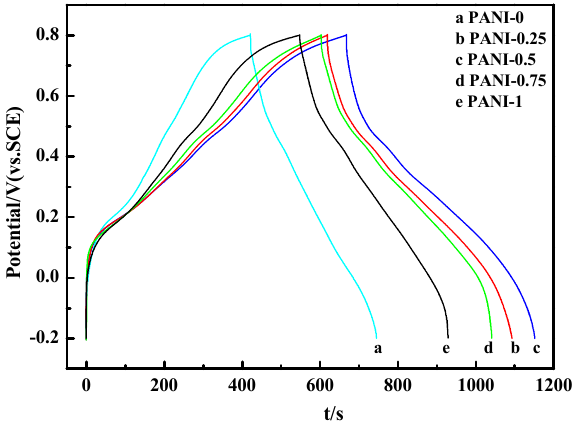
Figure 5. Charge-discharge of PANI salts at the same current density of 3 mA . cm − 2 in 1 M H SO electrolyte. 2 4